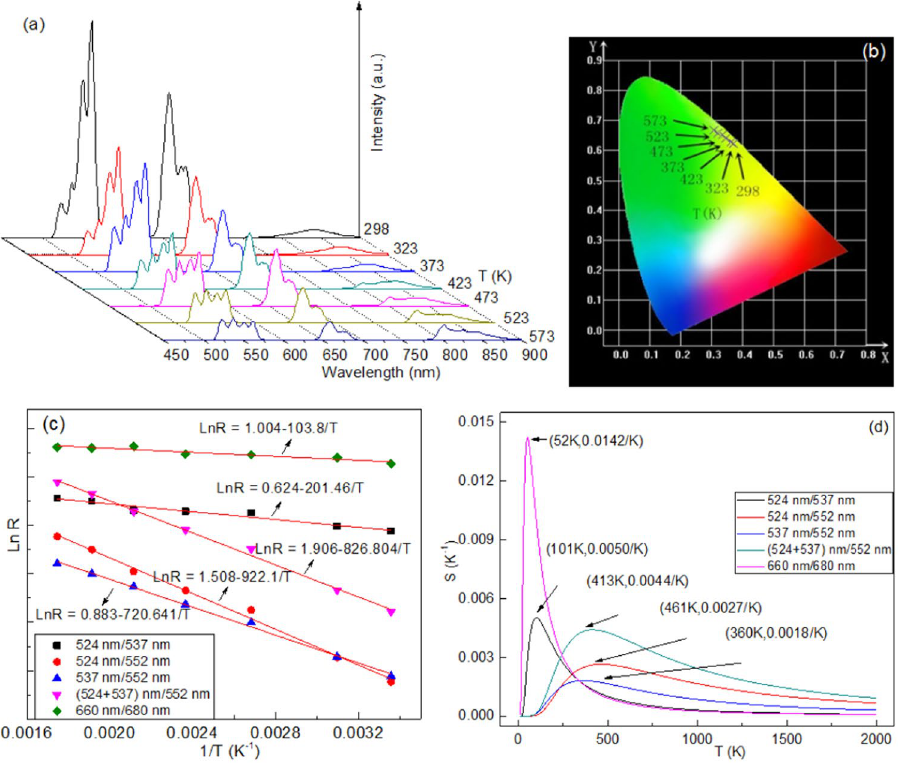
Figure 4. Temperature dependent ( a ) emission spectra, ( b ) CIE (X, Y) chromaticity coordinates diagram, ( c ) Arrhenius plots of emission intensity ratios, and ( d ) sensitivity of Y 2 O 3 :1%Er 3 + at 184 mW/mm 2